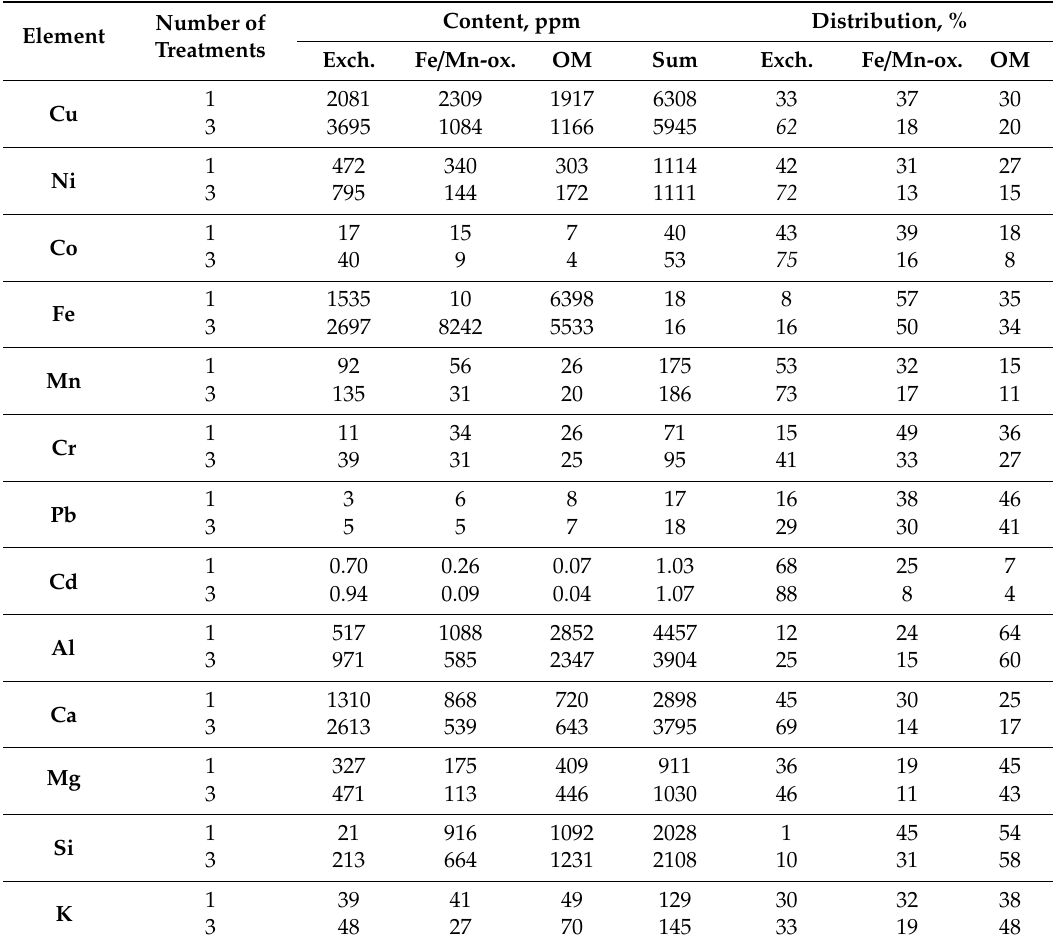
Figure 3. The ratio between the content of elements extracted by water ( a ) and AAB ( b ) in the 1st, 2nd, and 3rd treatment (100% is the total content of corresponding elements after three treatments). Table 3. The content of elements in geochemical